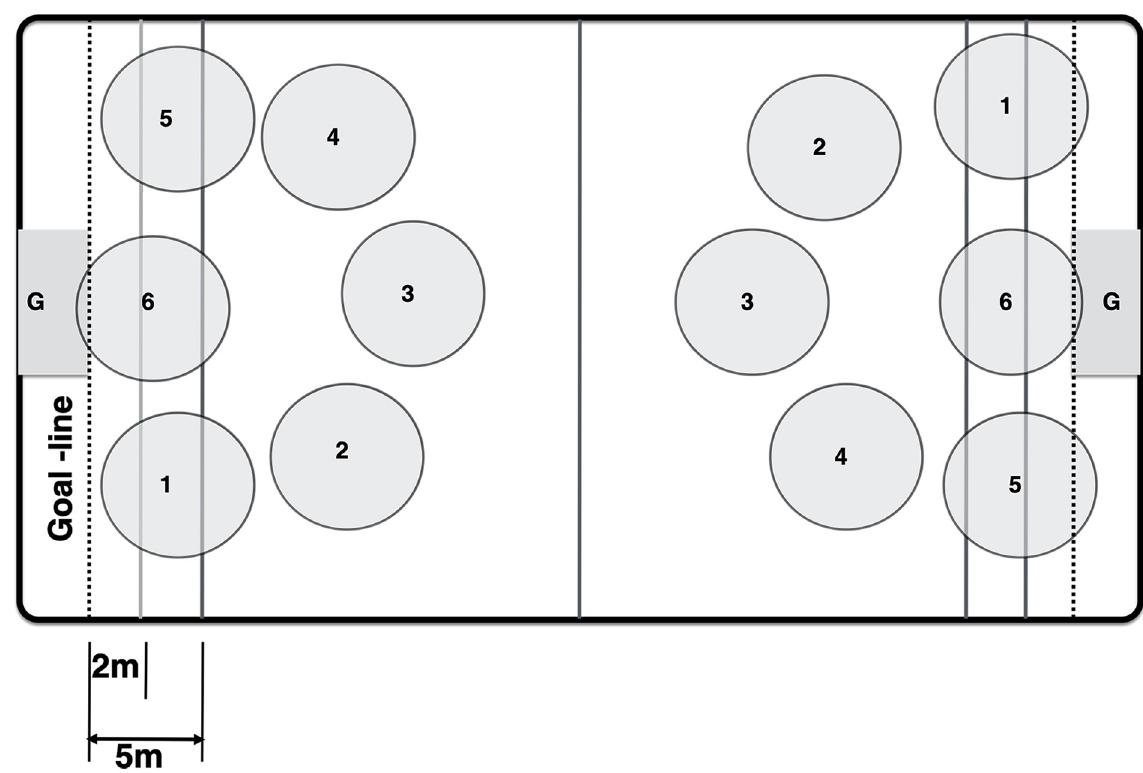
Fig 2. Locations of numbered player positions (1–6) and goalie (G) as observed in water polo games.